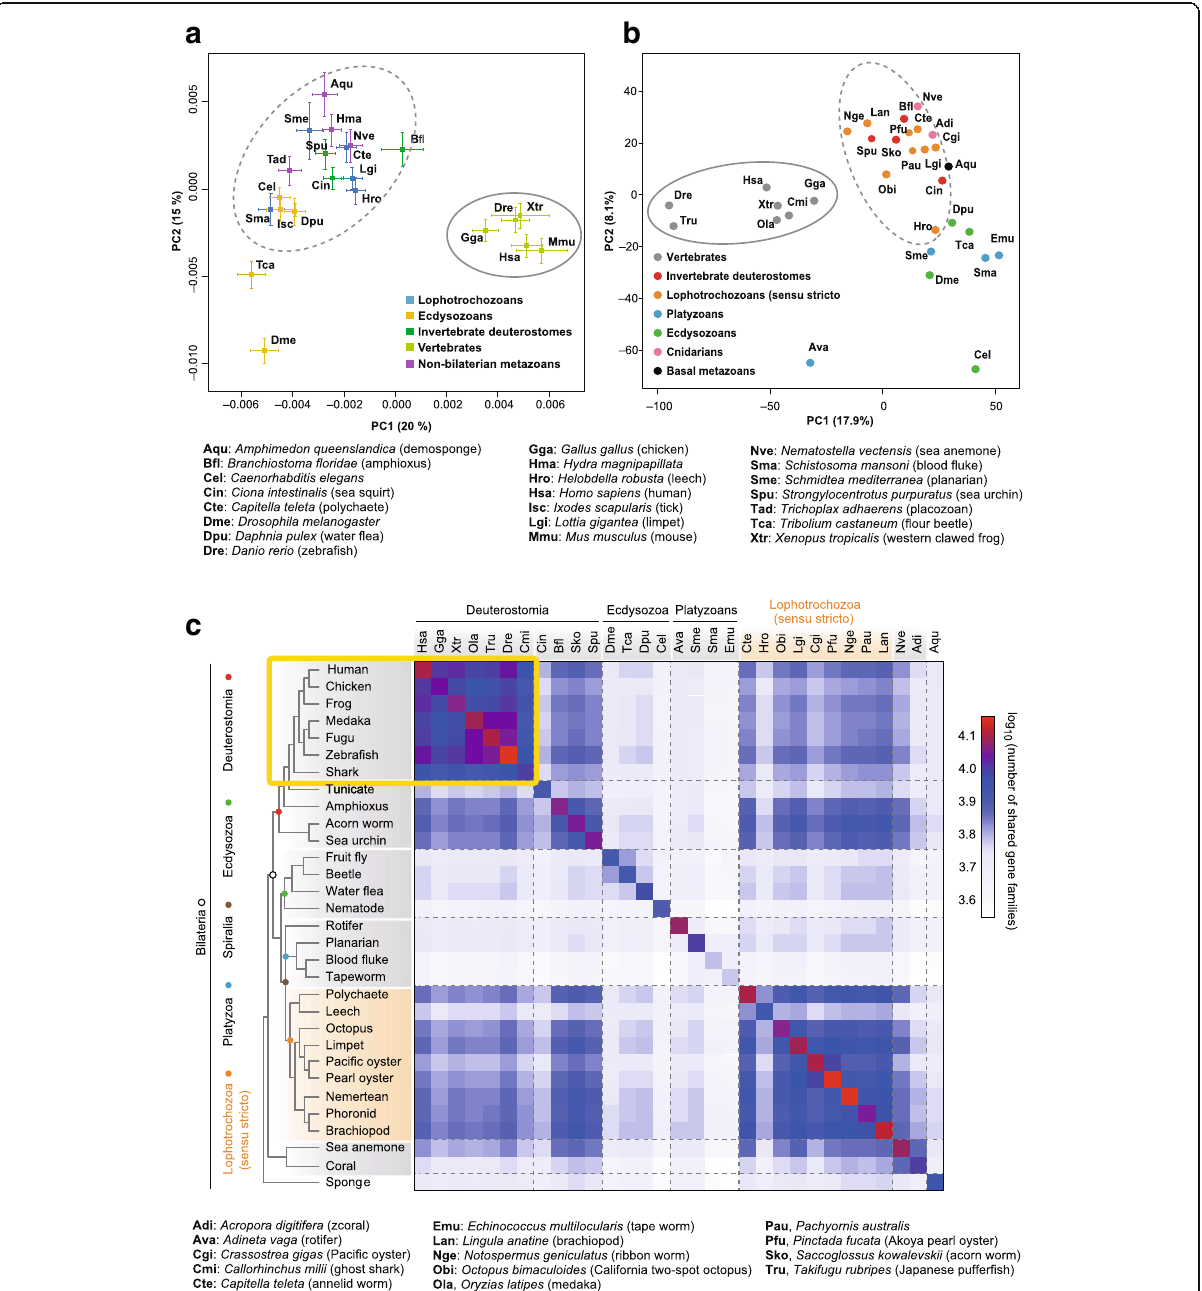
Fig. 4 Clustering of metazoan gene family composition. Shown are the results of two independent analyses performed by ( a ) Simakov et al. [35] and ( b, c ) Luo et al. [61]. The first two principal components are displayed. a Principal component (PC) analysis of annotated gene functions. At least three clusters are evident, namely a vertebrate cluster (far right; solid-line circle); a non-bilaterian metazoan, invertebrate deuterostome, or spiralian cluster (center, top; dashed-line circle), and an ecdysozoan group (lower left). Drosophila and Tribolium (lower left) are outliers. b PC analysis of PANTHER gene family sizes. Invertebrate deuterostomes (Bfl, Sko, and Spu) cluster with lophotrochozoans (dashed-line circle). Solid-line circle denotes the clustering of vertebrates. In addition to the metazoan species analyzed in ( a ), the following species were included in the analysis. c Matrix of shared gene families among selected metazoans. The cladogram on the left is based on phylogenetic positions inferred from this study. Dashed lines separate the major clades. Note that tunicates (Cin) and leeches (Hro) share fewer genes with other bilaterians, probably because of their relatively high evolutionary rates and gene loss in each